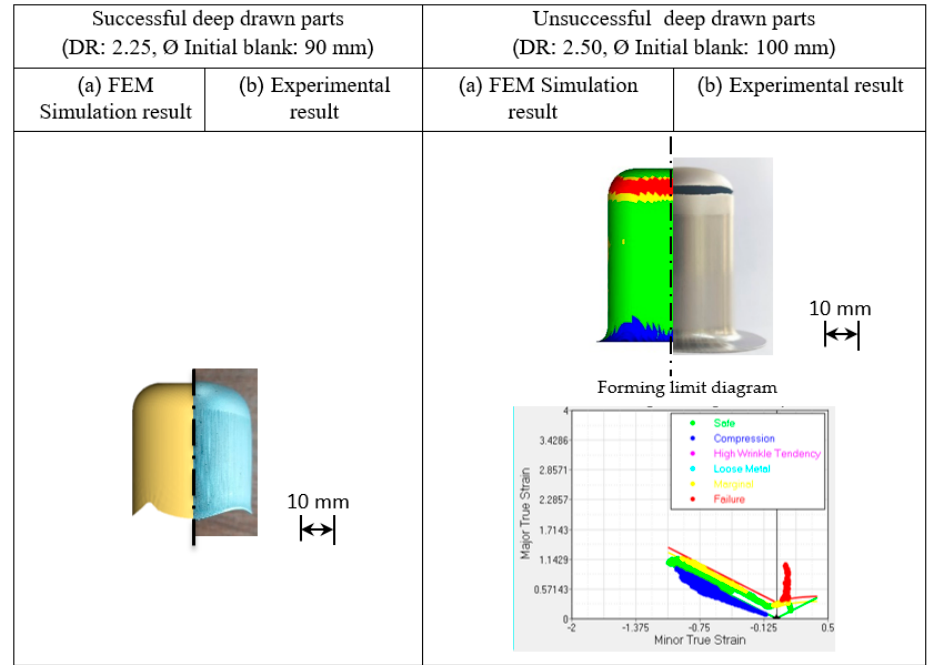
Figure 5. Comparison of deep drawn parts obtained by FEM simulation and experimental results: ( a ) FEM Simulation result; ( b ) Experimental result.